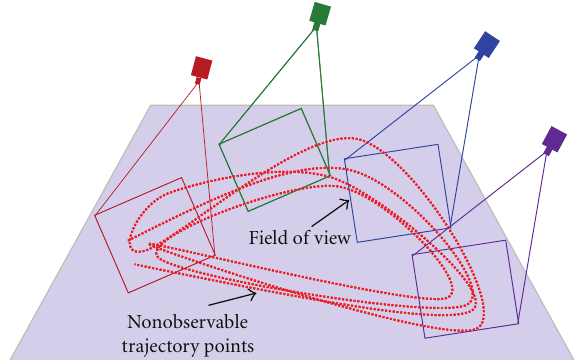
Figure 1: Example of camera network with nonoverlapping fields of